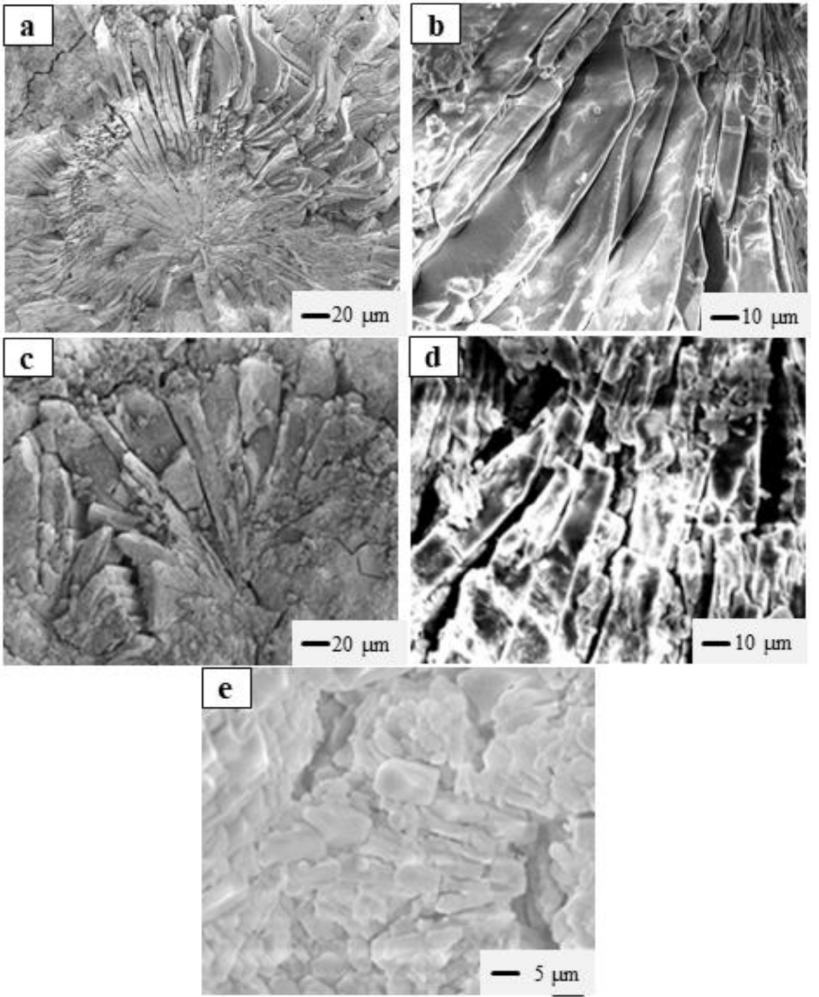
Figure 7. SEM images of SLMKPC samples with different W/C ratios after at 28 d of aging: ( a ) W/C = 0.2, ( b ) W/C = 0.25, ( c ) W/C = 0.3, ( d ) W/C = 0.35, ( e ) W/C =